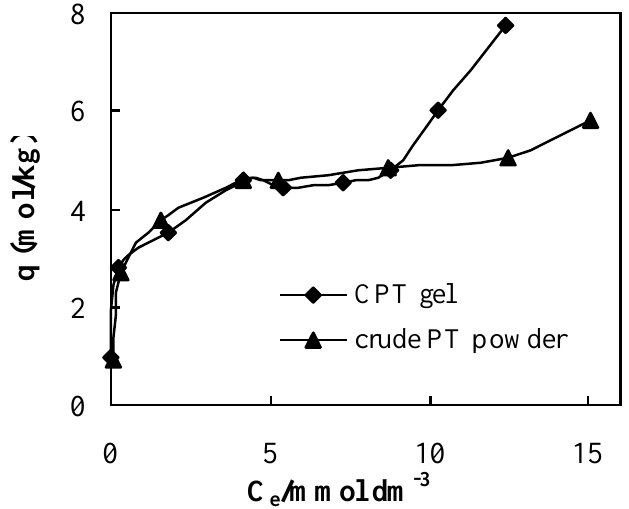
Figure 20. Adsorption isotherms of gold(III) on CPT gel and crude persimmon extract tannin (PT) powder from 0.1 mol·dm −3 hydrochloric acid solution [33] (with permission for reuse from Elsevier B.V.).